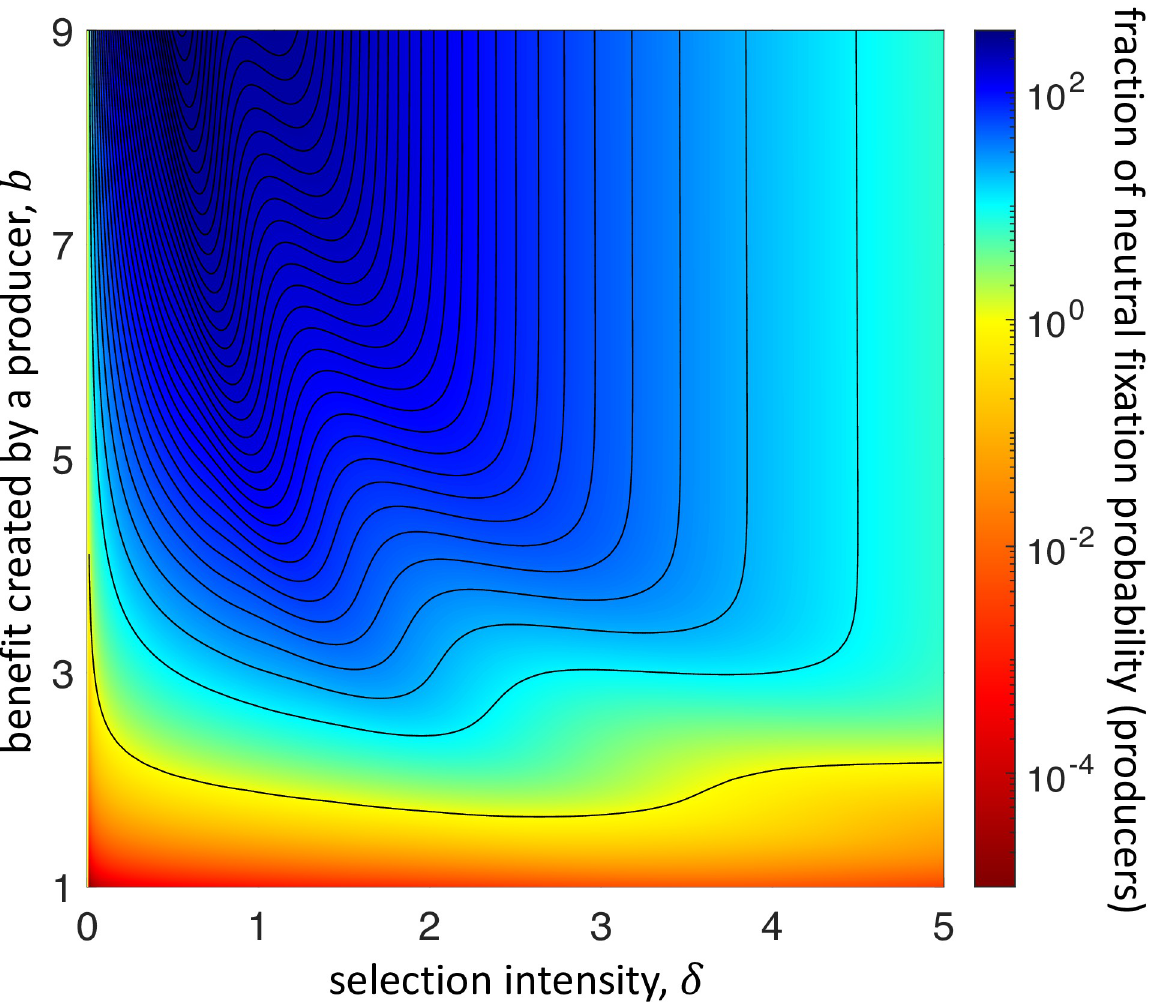
Fig 6. Fixation probability of producers of ff -goods on the star, under temperature initialization, as a function of selection intensity, δ , and the benefit created by a producer, b (exact calculations). The population size is N = 2000. The lowest contour line represents the region for which a producer’s fixation probability is the same as its neutral value. (Note that this neutral value does not depend on b .) Neighboring contour lines represent differences of 10 in the ratio of fixation probability to that of neutral drift. As b increases, the two peaks highlighted in Fig 5 persist, occur at smaller values of δ , and increase in magnitude. Notably, for moderately large δ beyond these peaks, the contour lines become approximately vertical. For fixed δ within this region, increasing b initially has little effect on a producer’s fixation probability. However, as b grows sufficiently large, this fixation probability does eventually decay to